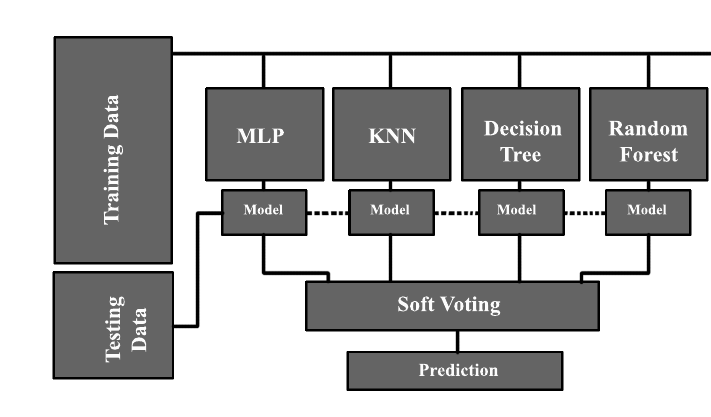
Figure 3. Ensemble Learning or Voting Classifier